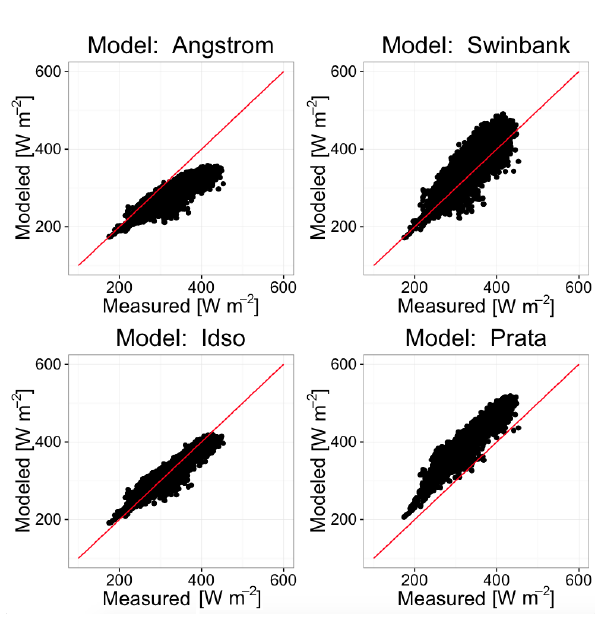
Figure 3. Results of the clear-sky simulation for four literature mod- els using data from Howland Forest